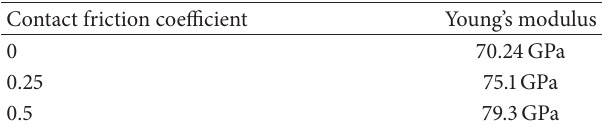
Table 3: The calculation